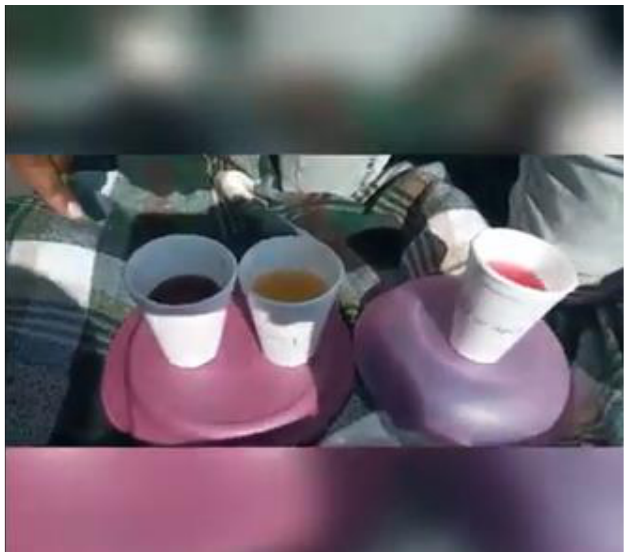
Figure 5. Group 5 experiment: showing that sugar may have a corrosive effect on